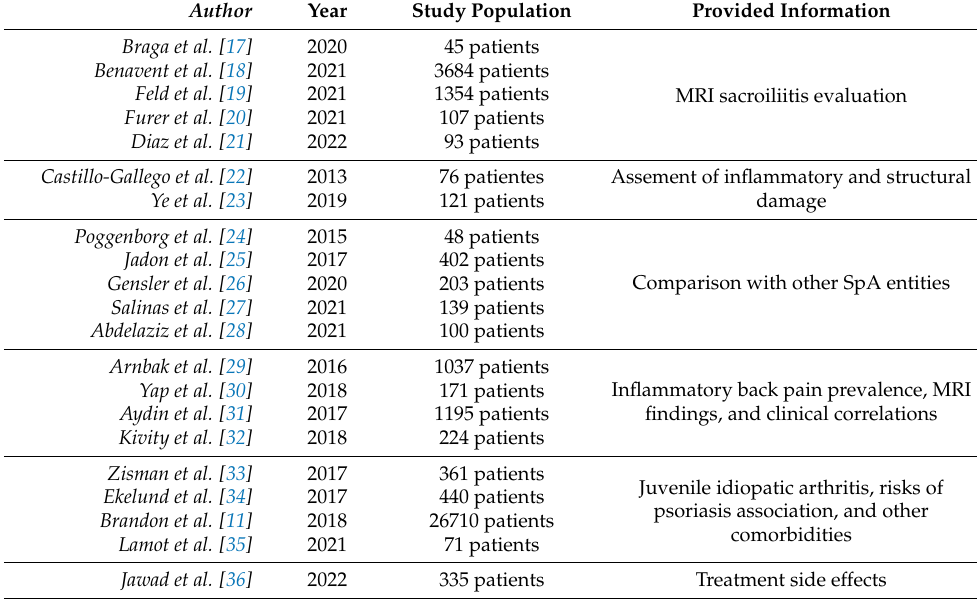
Figure 1. PRISMA flow chart of our study research. Table 1. Most relevant selected articles cited in this review.